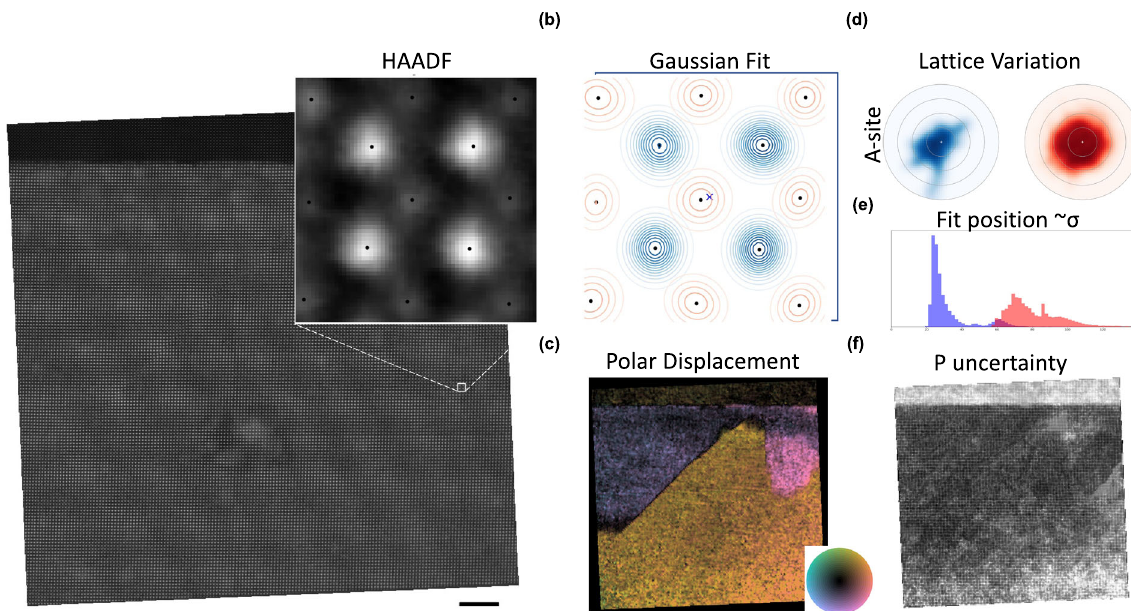
Fig. 1 Polarization mapping via atomic position parametrization. a HAADF-STEM image of a [100] psuedocubic BFO fi lm on STO substrate (top). Fe-centered perovskite unit-cell is shown inset. b Gaussian fi ts corresponding to inset region. Polar displacement, P , de fi ned as the vector between central Fe position and average Bi position (blue cross). c P distribution map corresponding to HAADF-STEM image in a , principal features are 109° (blue/gold) and 180° (gold/pink) domain walls. Color legend maximum radius corresponds to 50 pm. d Heat map of variation from uniformity for Bi A-site (blue) and Fe B-site (red) sublattices, each band corresponds to 25 pm. RMS values are 9.7 pm and 14.6 pm, respectively. e Histogram of uncertainty estimates from fi tting for Bi A-sites (blue) and Fe B-sites (red). f Distribution of P uncertainty. Scalebar is 5